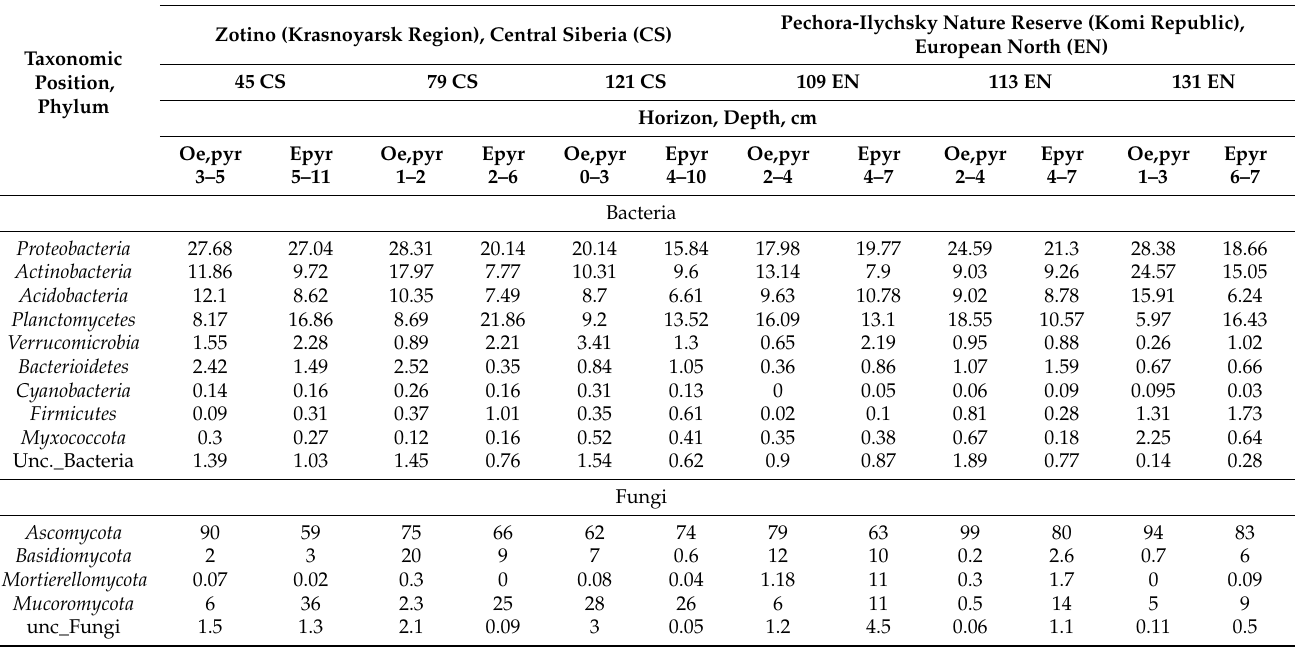
Table 4. Relative content of prokaryotes and fungi at the type level in samples from the studied sites, averaged data by horizons,